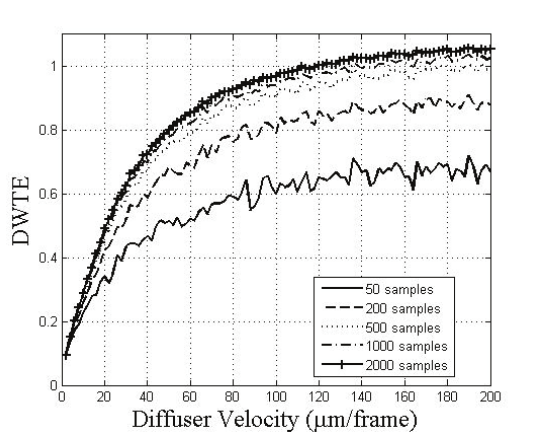
Fig. 9 Shannon Entropy descriptor ( SE )